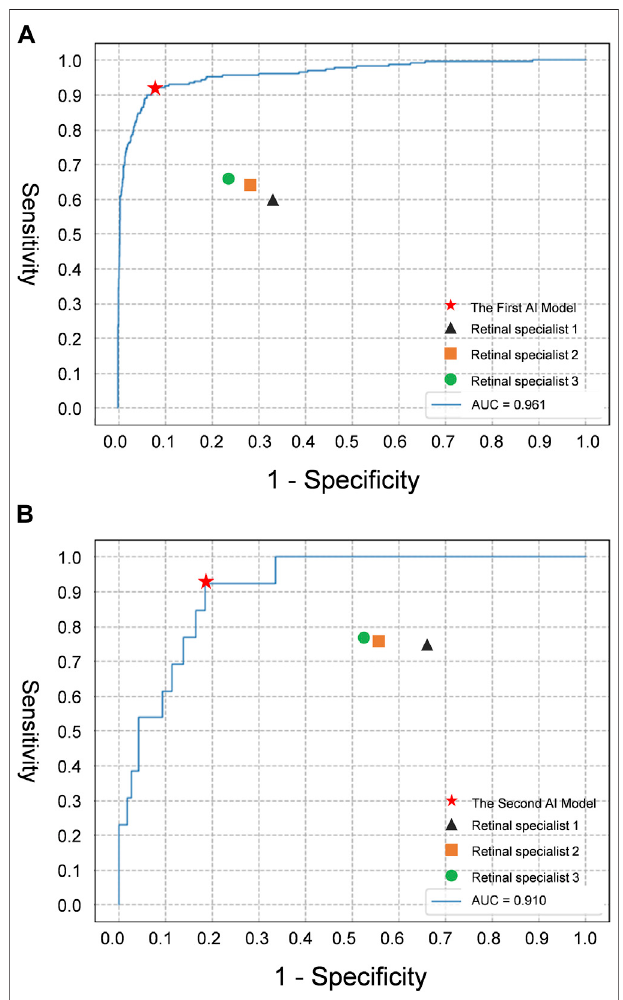
FIGURE 5 | The receiver operating characteristic curve of the deep learning models for evaluating CSC depicted on fundus images, compared with retinal specialists ’ performance. (A) Detection performance of SRD; (B) Detection performance of macula-on SRD. AUC area under the receiver operating characteristic curve; Retinal specialist 1, 3 years of working experience;retinalspecialist2,5 yearsofworkingexperience;retinalspecialist 3, 10 years of working